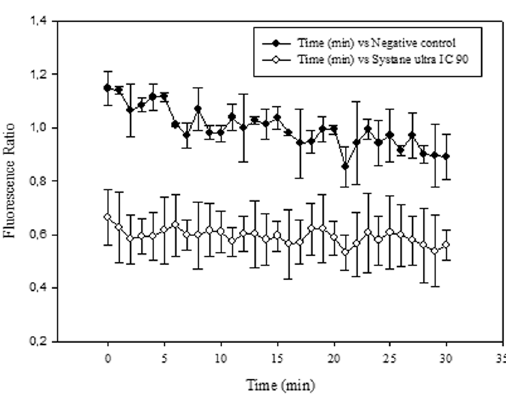
Figure 5. Mitochondrial membrane potential ( Δψ m ) Showing change in the Ratio of fluorescence intensity at 590/530 nm after the 24 hours of treatment with the IC 90 of Systane Ultra. (Filled diamond shapes vehicle only control, empty diamonds with Systane